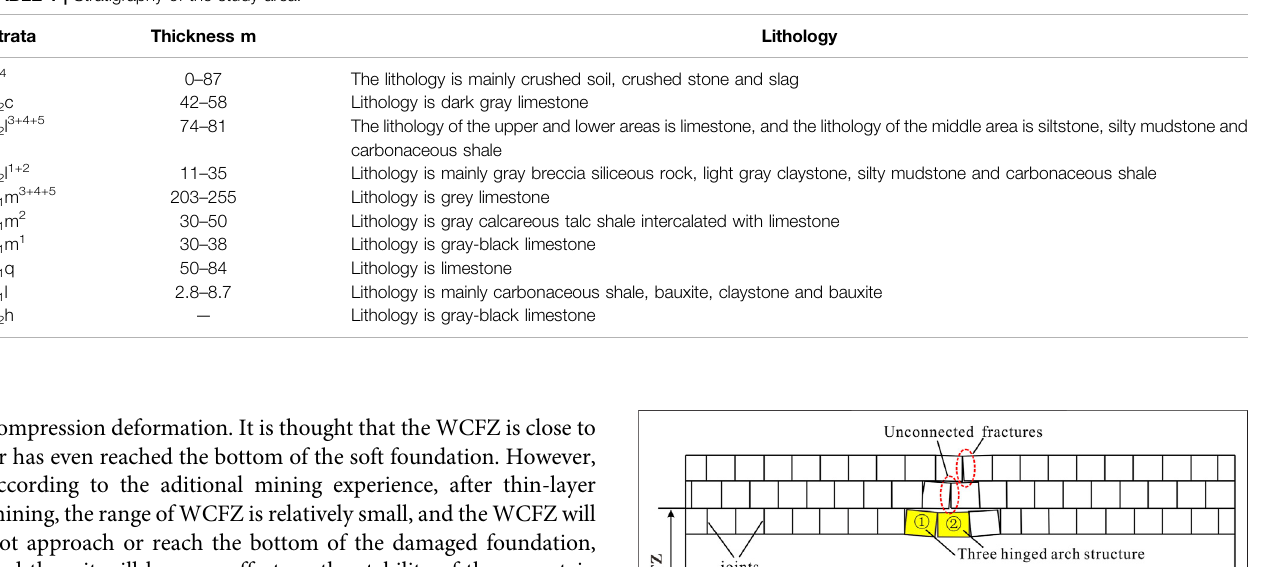
TABLE 1 | Stratigraphy of the study area.